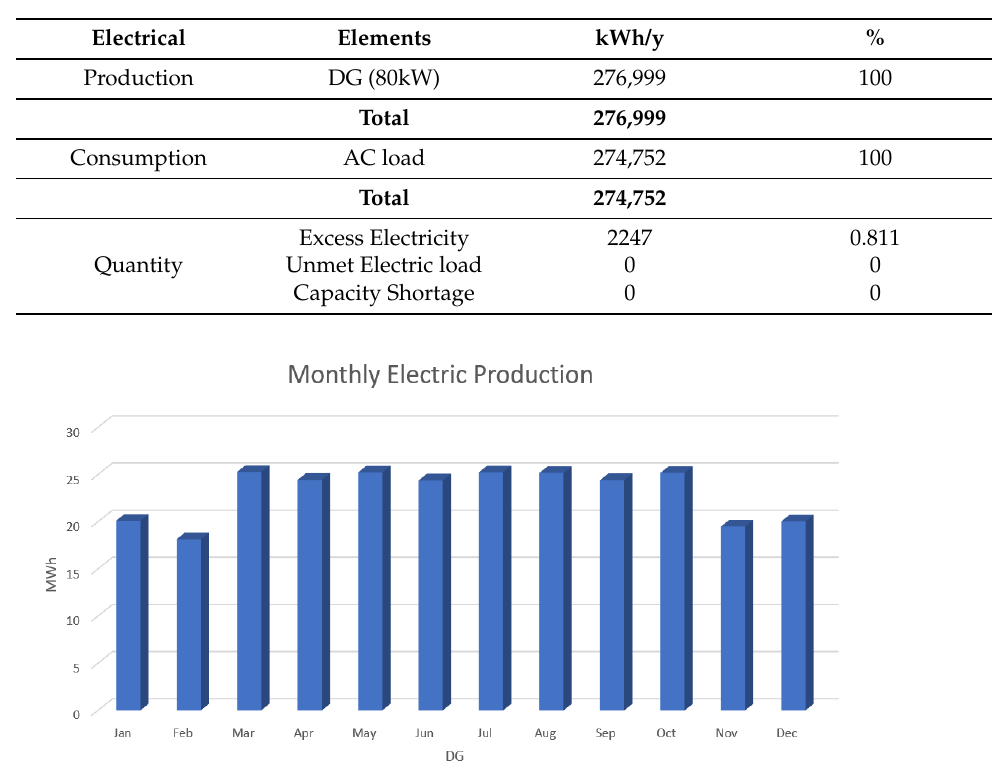
Table 4. Augmented Electrical Result for DG.